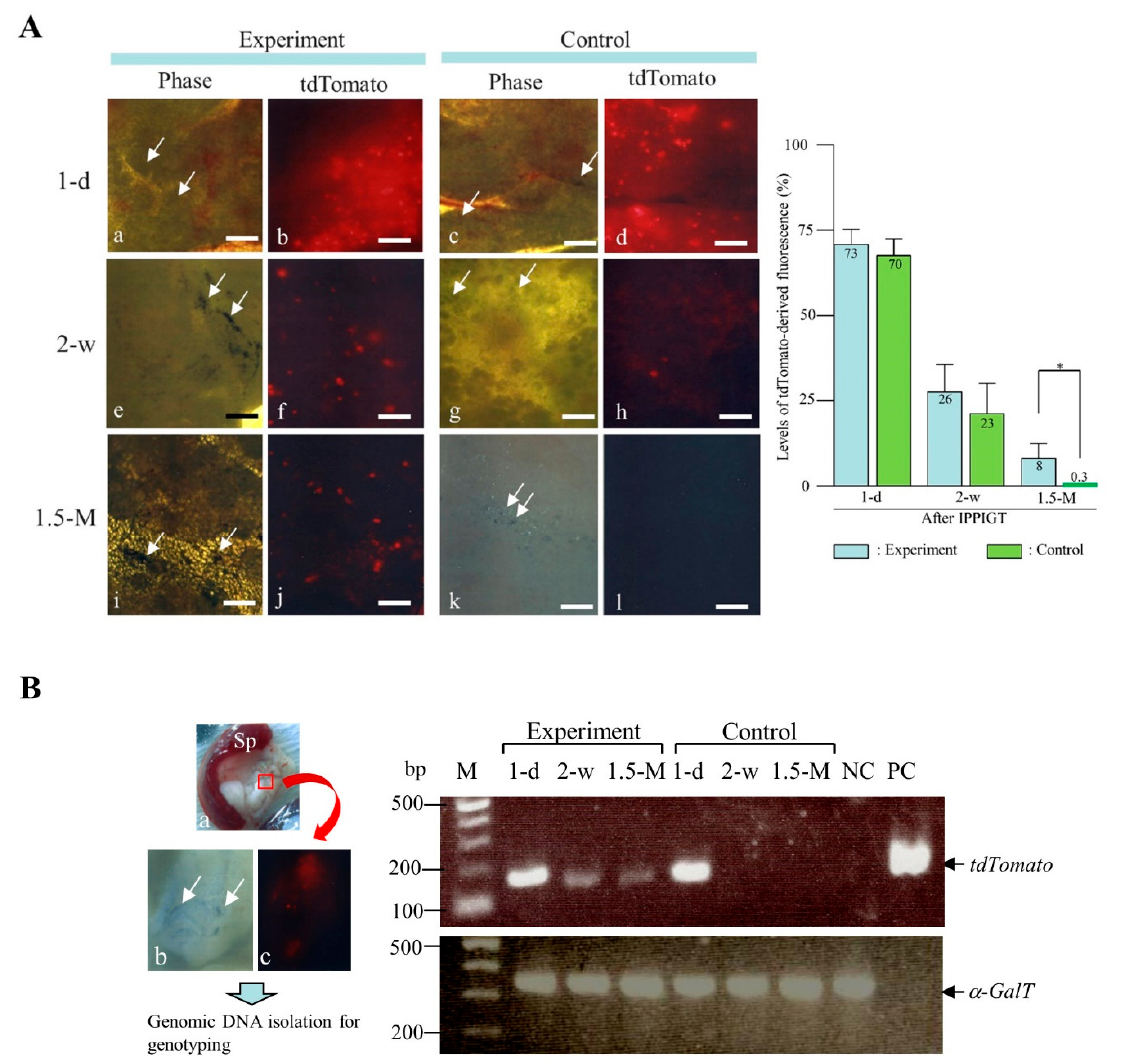
Figure 2. Inspection of the tdTomato-derived fluorescence and PCR analysis of pancreas dissected at 1 day (1-d), 2-w (2 weeks), and 1.5-M (1.5 months) post-IPPIGT with pTrans + pT-tdTomato (Experiment) or pT-tdTomato alone (Control). ( A ) Fluorescence in intact samples (left panel). Arrows indicate the presenceofTBthatmarksthesiteswhereDNAwasinjected. Phase, photographstakenunderwhitelight; tdTomato, photographs taken under white light + UV. Bar = 1 mm. Quantification of tdTomato-derived fluorescence in samples after IPPIGT (right panel). The mean fluorescence level ± SD was graphically represented. The number shown at the top of each column indicates the mean fluorescence level (%). * represents p < 0.02. ( B ) PCR analysis of pancreatic tissue. Transposons in the experimental or control group shown in ( A ) were subjected to IPPIGT, and the injected portion (enclosed by quadrant shown in a of the left panel), which is visible by the presence of TB (shown by arrows in b) and shows tdTomato-derived fluorescence (shown in b,c of the left panel), was isolated 1-d, 2-w and 1.5-M post-IPPIGT for genomic DNA isolation. Samples from each group were then subjected to PCR analysis (right panel). The same samples were also subjected to PCR using primers to detect the endogenous α -GalT gene ( GGTA1 ). M, 100-bp ladder markers; lane NC, intact murine tail DNA; lane PC, control plasmid DNA (pT-tdTomato for detection of tdTomato